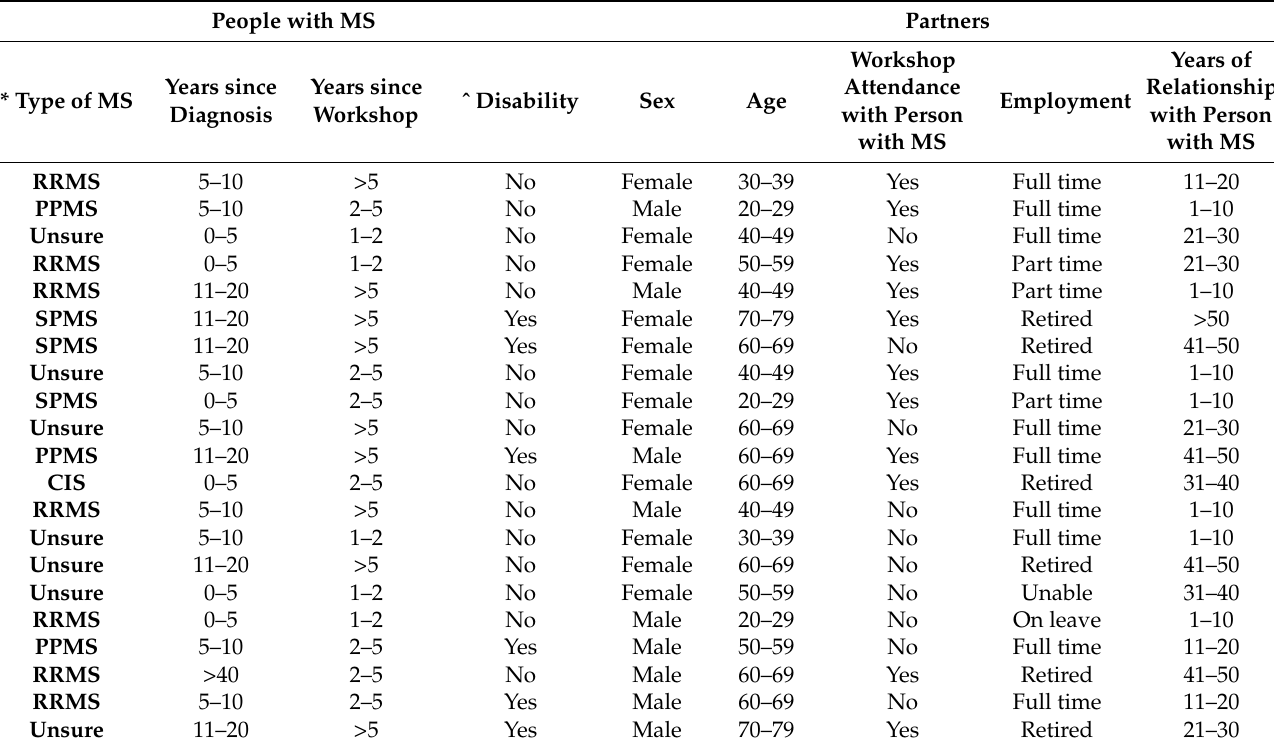
Table 1. Demographic data of people with MS and partners (participants) as reported by participants. People with